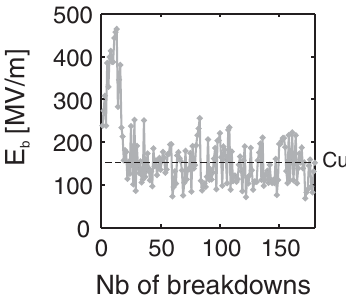
FIG. 8. Conditioning curve of superficially oxidized